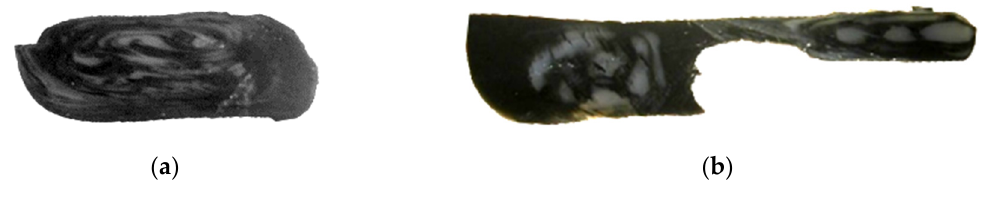
Figure 20. Micro sections after a wave crest ( a ) and on a wave crest ( b ).